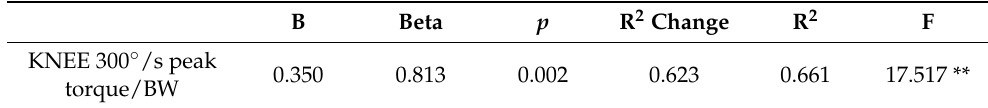
Table 3. Stepwise regression analysis for prediction of VO 2peak .